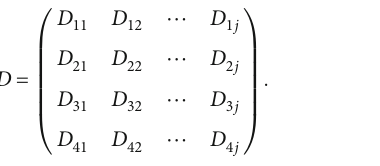
j of EEG data D ij represents the expected value of index for proposal i ( i = 1, 2, 3, 4 ). In this experiment, the observed electrodes and overlapping topographic maps are shown in Figure 5. According to the brain topographic map, 11 elec- trodes were selected in the most active area, named F4, F7, F8, FZ, FC1, FC2, FC5, FC6, ft9, ft10, and F3; therefore, in